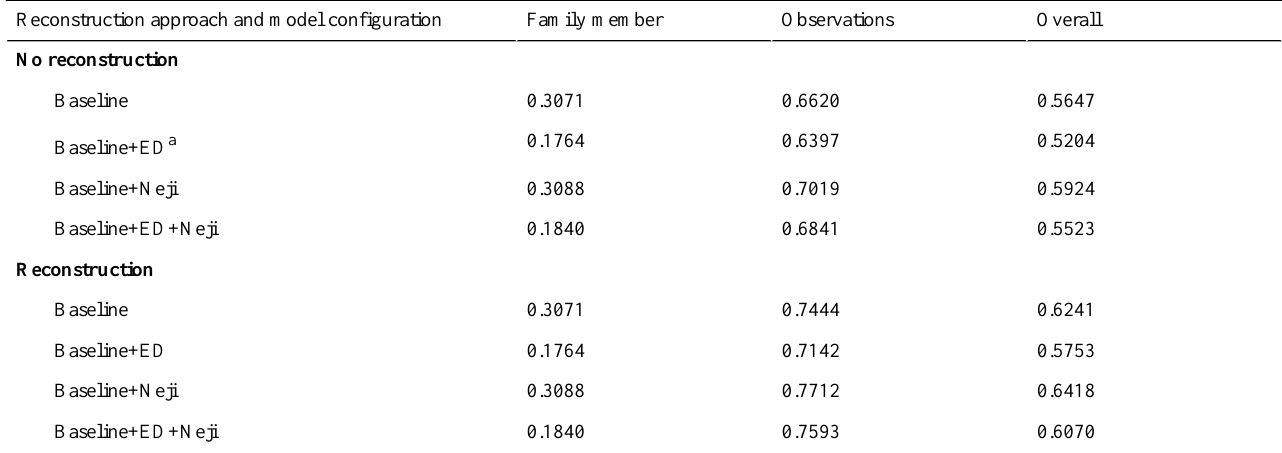
Table 4. Cross validation results on the training data set (5-fold cross validation) for subtask 1 using a deep learning model composed of clinical bidirectional encoder representations from transformers embeddings, a linear layer, and softmax function, with and without token reconstruction. For simplicity purposes, only F1 scores are